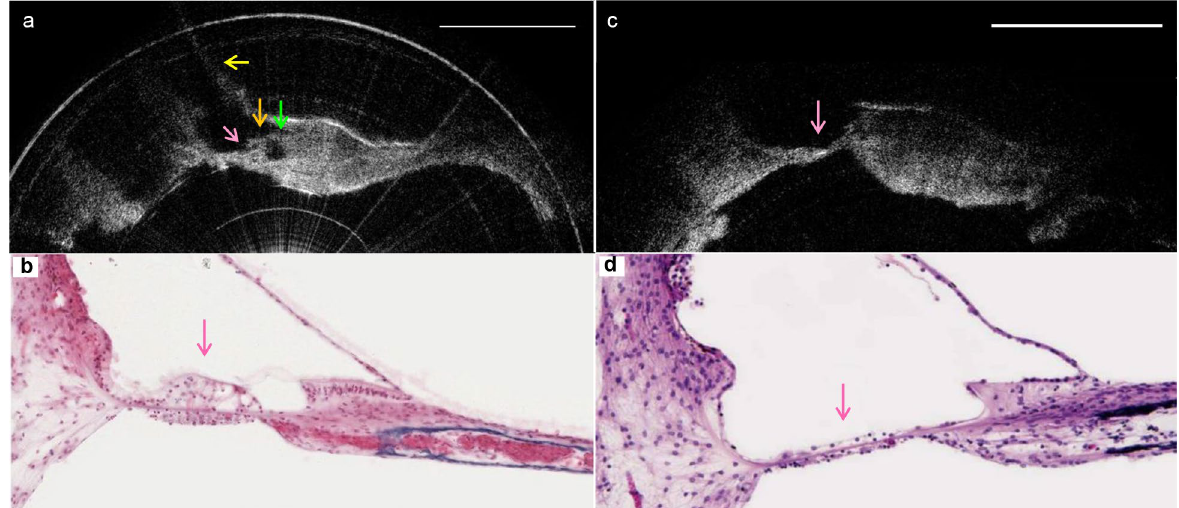
Figure 6. Circularized μOCT images of the human cochlea’s interior, acquired using a μOCT endomicroscope inserted through the round window and positioned within scala tympani. ( a ) Region of intact organ of Corti, showing structures that indicate the region of hair cells (magenta), the spiral limbus (green), and the tectorial (orange) and Reissner’s (yellow) membranes. ( b ) Shows a histological section acquired from a healthy region of human organ of Corti 12 (magenta). ( c ) Hypothesized region of damaged organ of Corti (magenta) in the hook region of a human cochlea, showing flat epithelium morphology. ( d ) Shows a histological section acquired from a damaged region of human organ of Corti 12 (magenta). All scales = 50